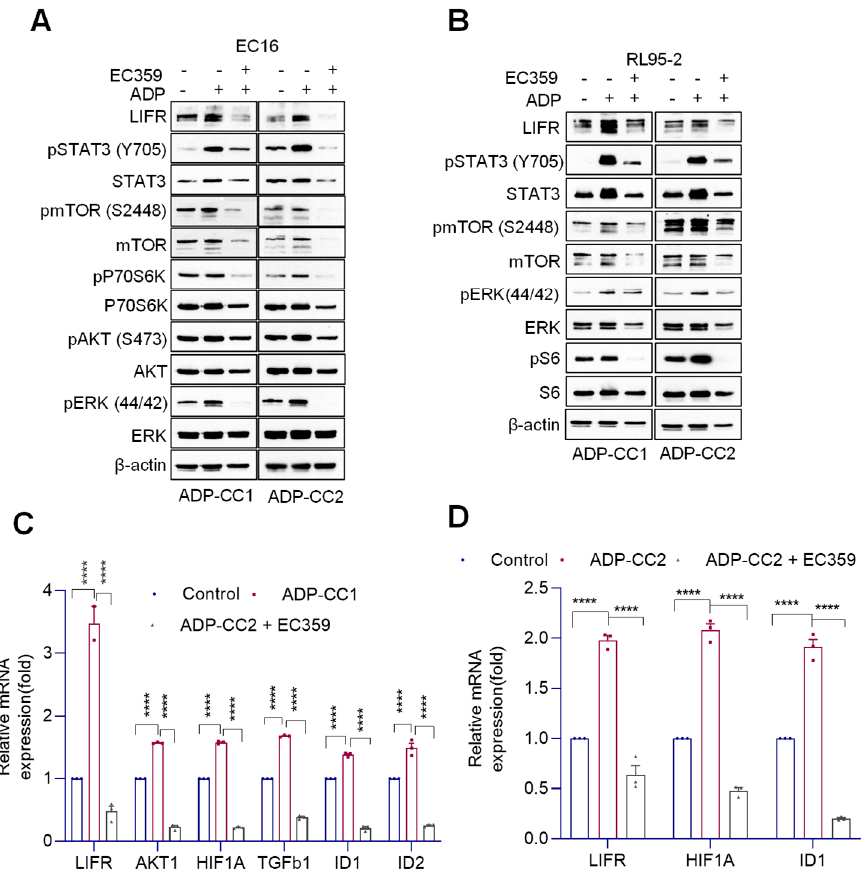
Figure 5. EC359 reduced LIFR downstream signaling in EEC cells co-cultured with adipocytes. ( A , B ), primary EEC (EC16) ( A ) and RL95-2 ( B ) cells were co-cultured with adipocytes (ADP-CC1 and ADP-CC2) for 24 h with or without EC359, and the expression of LIFR and downstream signaling proteins were analyzed using Western blot analysis. ( C , D ) Effect of EC359 treatment using RL95-2 cells co-cultured with ADP-CC1 ( C ) and ADP-CC2 ( D ) for 24 h on LIFR-targeted genes was measured using RT-qPCR. Data are represented as mean ± SE. **** p < 0.0001.